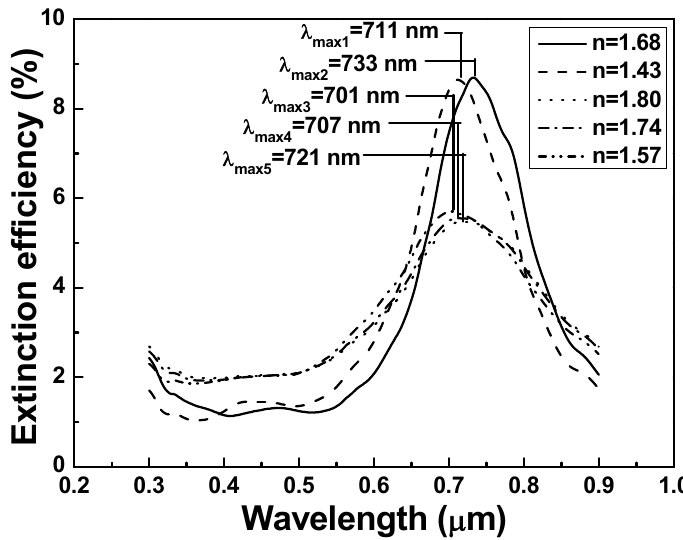
Figure 2. The extinction spectra results of compound nanostructure arrays as a function of substrate with different refractive